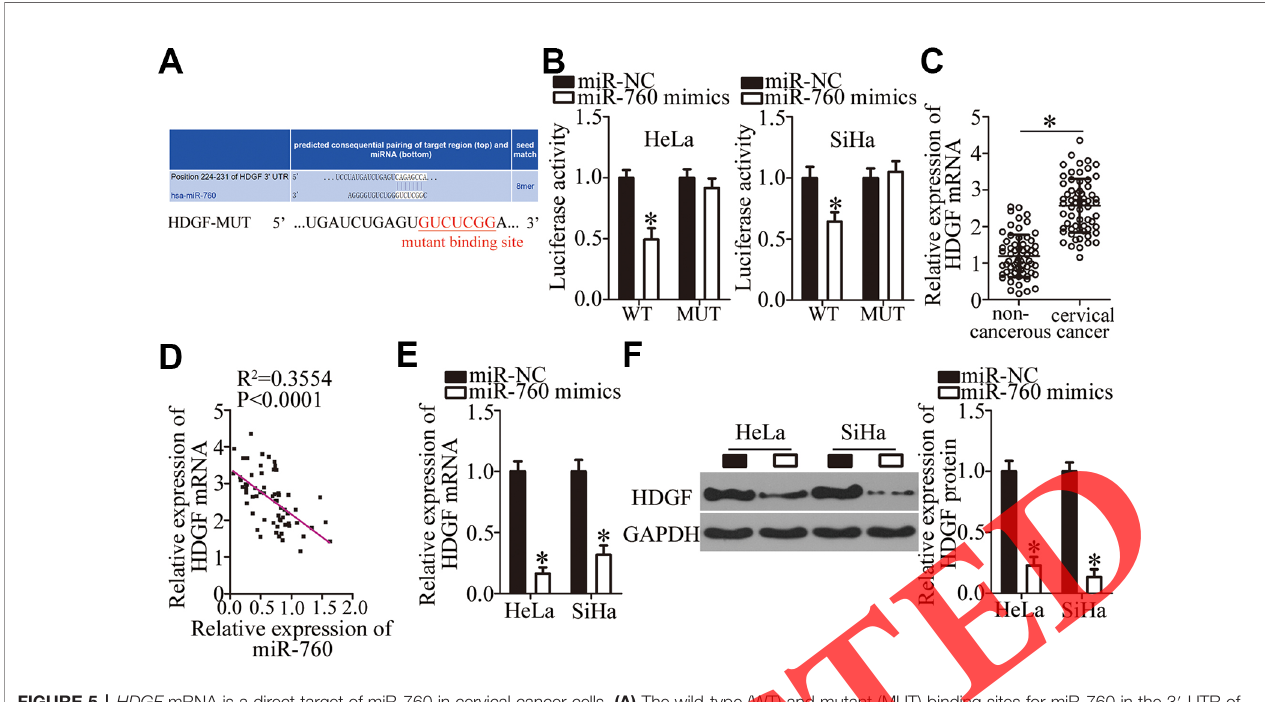
FIGURE 5 | HDGF mRNA is a direct target of miR-760 in cervical cancer cells. (A) The wild-type (WT) and mutant (MUT) binding sites for miR-760 in the 3 ′ -UTR of HDGF mRNA as predicted by bioinformatics analysis. (B) The luciferase reporter assay was performed on HeLa and SiHa cells that were cotransfected with either the miR-760 mimic or miR-NC and a luciferase reporter plasmid carrying the WT or Mut 3 ′ -UTR of HDGF . *P < 0.05 vs group miR-NC. (C) HDGF mRNA expression was assessed by RT-qPCR in 63 pairs of cervical cancer tissue samples and samples of adjacent noncancerous tissues. *P < 0.05 vs noncancerous tissue samples. (D) Spearman ’ s correlation analysis was applied to investigate the relation between miR-760 and HDGF mRNA levels in cervical cancer tissue samples. R 2 = 0.3554; P < 0.0001. (E, F) The mRNA and protein levels of HDGF in HeLa and SiHa cells transfected with either the miR-760 mimic or miR-NC were measured by RT-qPCR and western blotting, respectively. *P < 0.05 vs the miR-NC